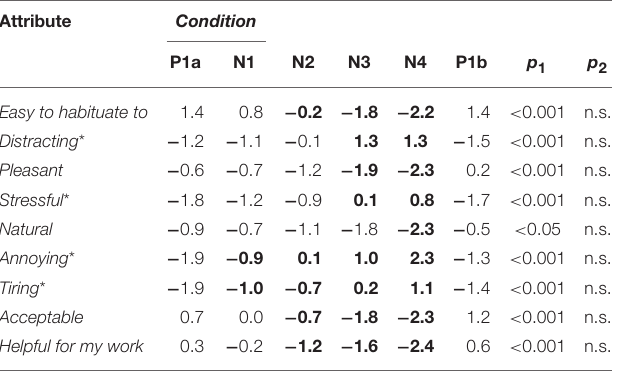
Scale: − 3Stronglydisagree, + 3Stronglyagree.Boldfontmeansthattheconditiondiffers significantly from condition P1a. Large value is desirable except for negative attributes labeled with asterisk * .